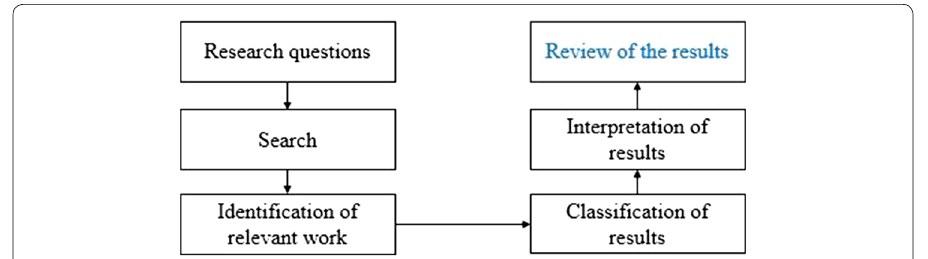
Fig. 2 Adopted systematic mapping process. The figure depicts the systematic mapping and reviewing process adopted in this study, which is proposed by Petersen et